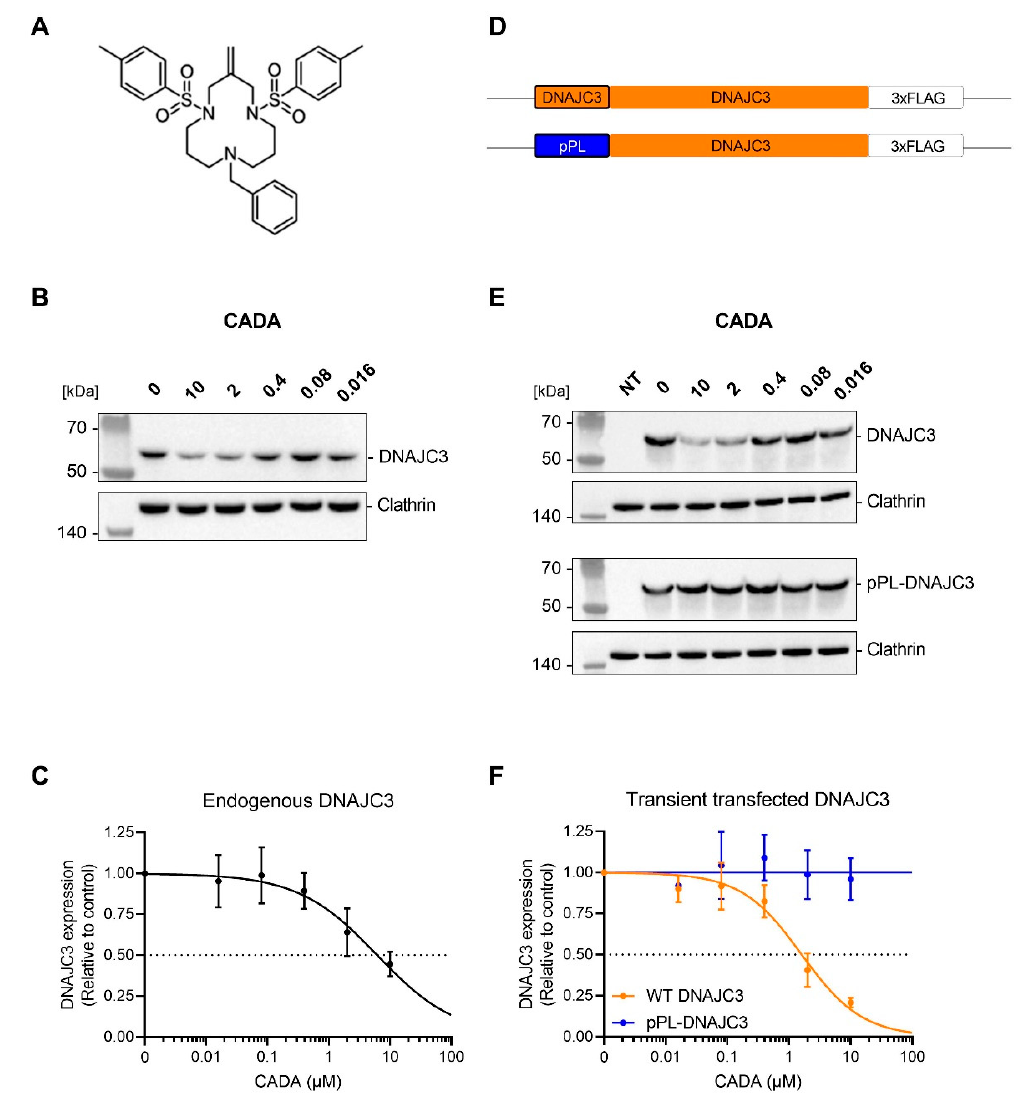
Figure 1. CADA sensitivity of endogenous and transfected DNAJC3 in HEK293T cells. ( A ) Chemical structure of CADA. ( B ) Western blot images of cell lysates from HEK293T cells treated for 24 h with different CADA concentrations. Protein bands were visualized with an antibody against DNAJC3 and an anti-clathrin antibody was used for the cell loading control. One representative experiment out of four is shown. ( C ) Concentration–response curves of CADA for endogenous DNAJC3 expression in HEK293T cells. Samples from ( B ) were quantified and normalised to the clathrin internal control. A four-parameter concentration–response curve was fitted to the data from four replicate experiments. Values are mean ± SD; n = 4. ( D ) Schematic representation of the DNAJC3 variants, with different signal peptides. ( E ) Western blot images of cell lysates from non-transfected (NT), DNAJC3-FLAG- or pPL-DNAJC3-FLAG-transfected HEK293T cells treated for 24 h with different CADA concentrations. Protein bands were visualized with an antibody against the FLAG tag and an anti-clathrin antibody was used for the cell loading control. One representative experiment out of five is shown. ( F ) Concentration–response curves of CADA for DNAJC3- and pPL-DNAJC3-transfected HEK293T cells. Samples from ( E ) were quantified and normalised to the clathrin internal control. A four-parameter concentration–response curve was fitted to the data from at least four replicate experiments. Values are mean ± SD; n ≥ 4. CADA: cyclotriazadisulfonamide; HEK293T: human embryonic kidney 293T cells; DNAJC3: DnaJ homolog subfamily C member 3; pPL: pre- prolactin.